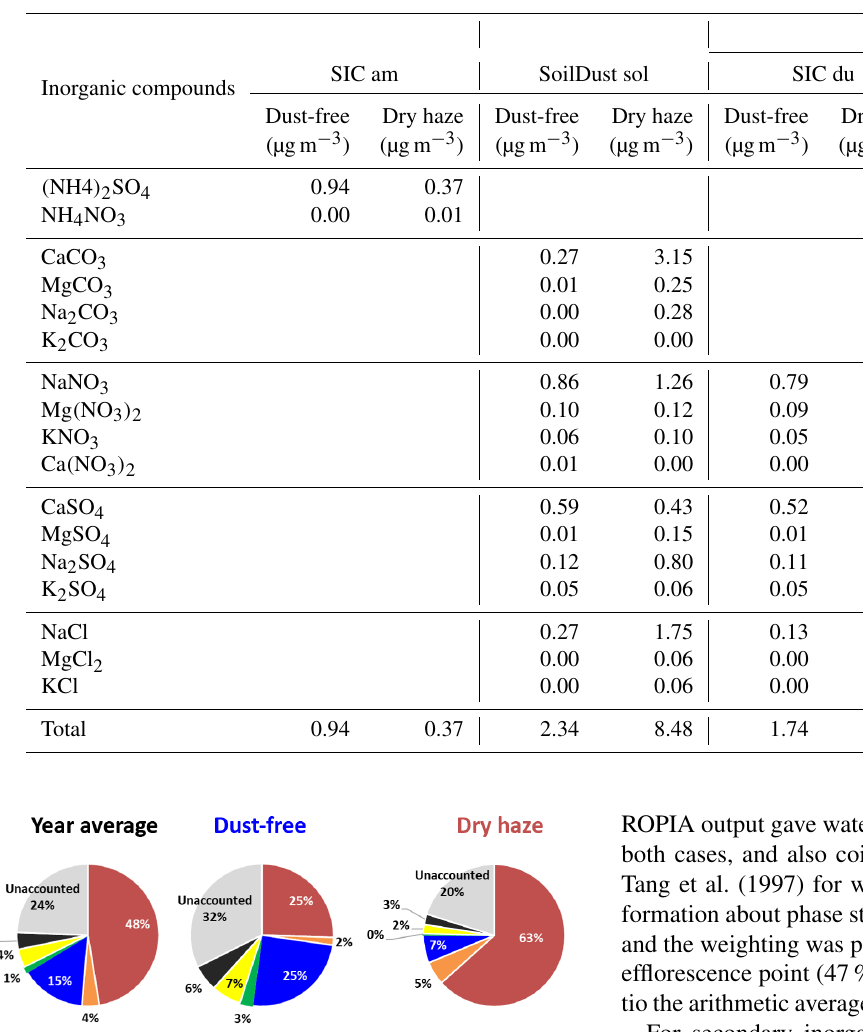
Table 2. Soil and secondary inorganic compounds resulting from the ionic balance.